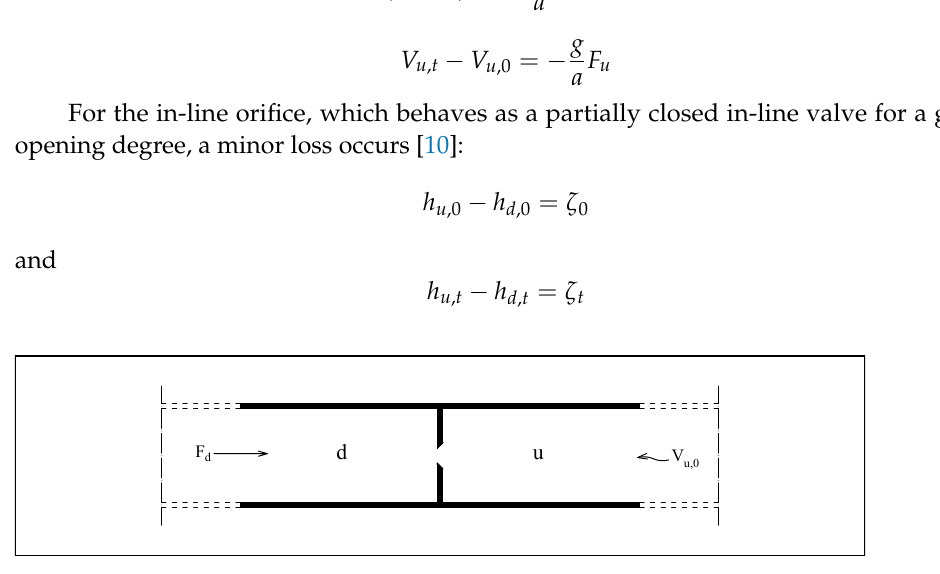
Figure 2. Sketch of discrete partial blockage: in-line